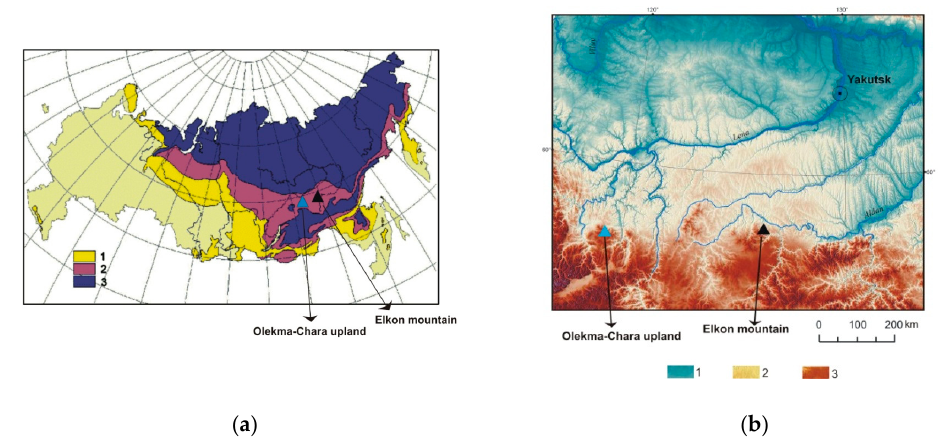
Figure 1. Study areas. ( a ) Location of study areas shown on the permafrost map of Russia (1—permafrost islands; 2—discontinuous permafrost; 3—continuous permafrost). ( b ) Location of